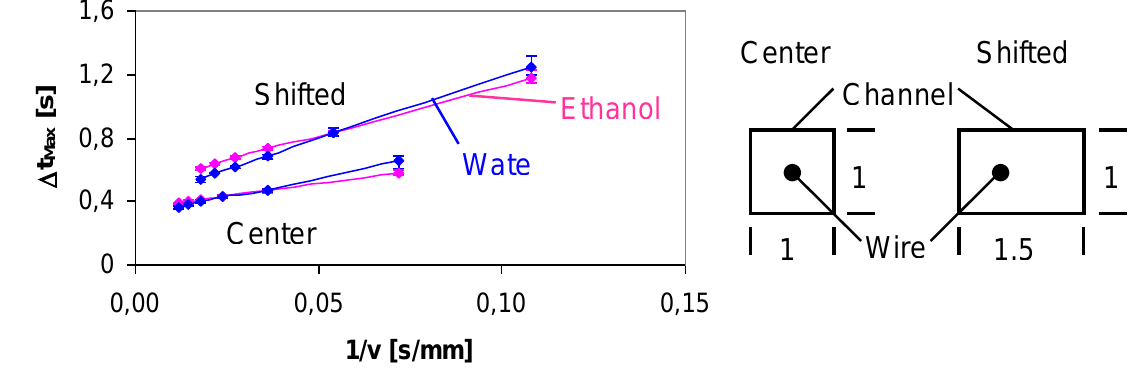
Figure 3. Time of flight ∆t for water and ethanol as a function of the inverse of the Max mean flow velocity for a center and a shifted position of the flow parallel wire (FPW).